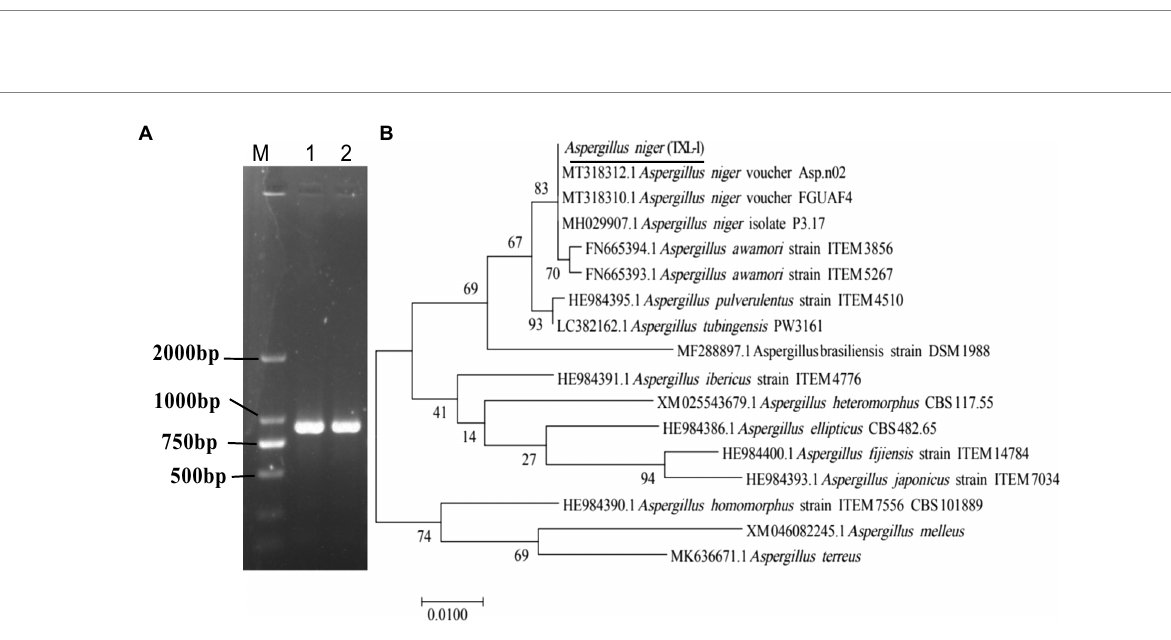
FIGURE 5 Molecular identification of fungal strains. (A) PCR results of the pathogen using EF-1 sequences; (B) phylogenetic tree based on EF-1 sequences; (M) marker DL2000; (1, 2) two replications.